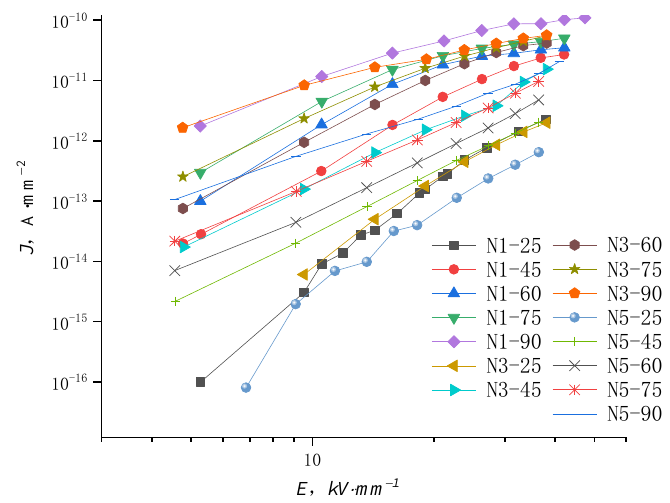
Figure 9. J-E characteristic curves of nano-ZnO/LDPE in different temperatures.